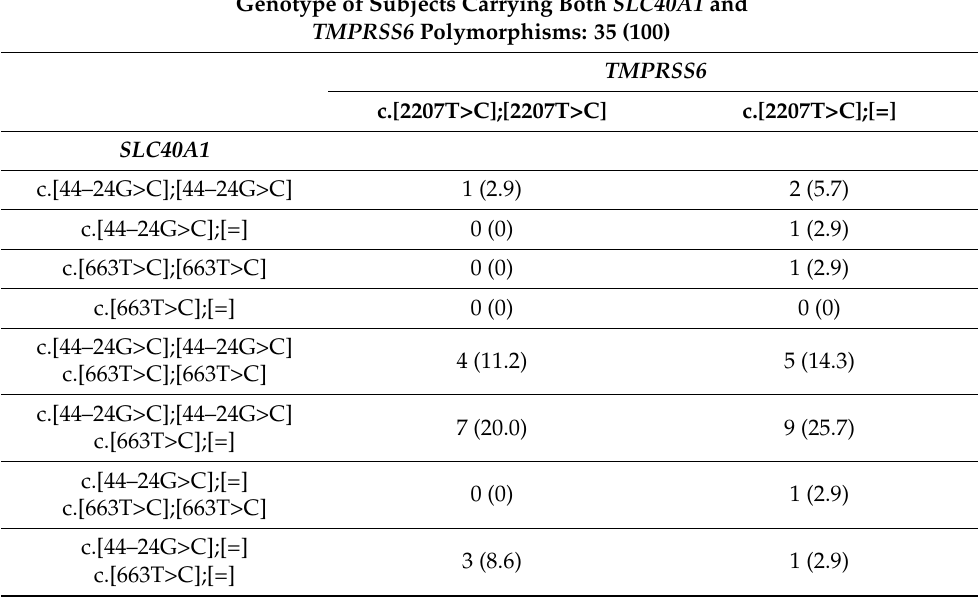
Table 3. The number and genotype percentage of participants carrying both SLC40A01 and TMPRSS6 SNPs. The genotype percentage is given in brackets.